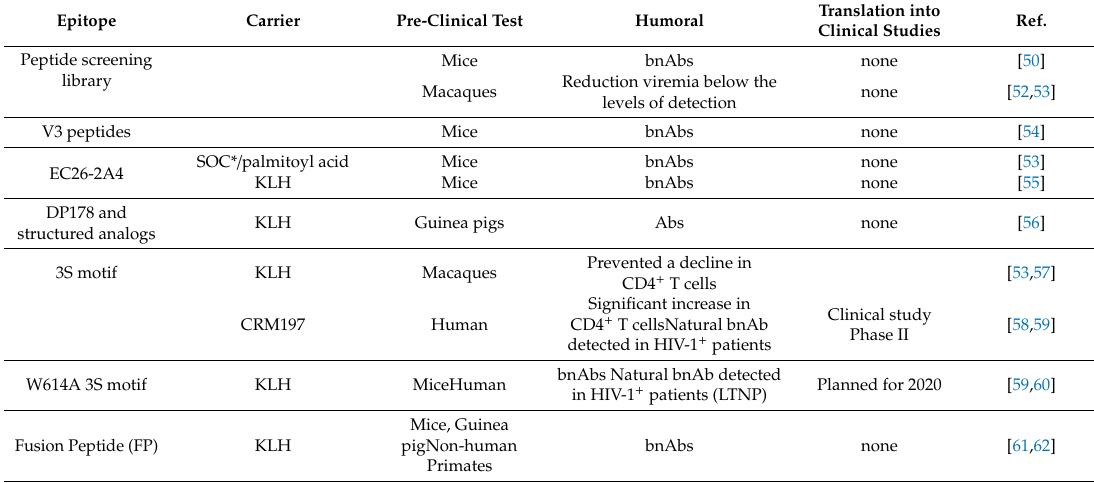
Table 1. List of peptide discovery-based HIV vaccine candidates inducing non neutralizing and neutralizing antibody